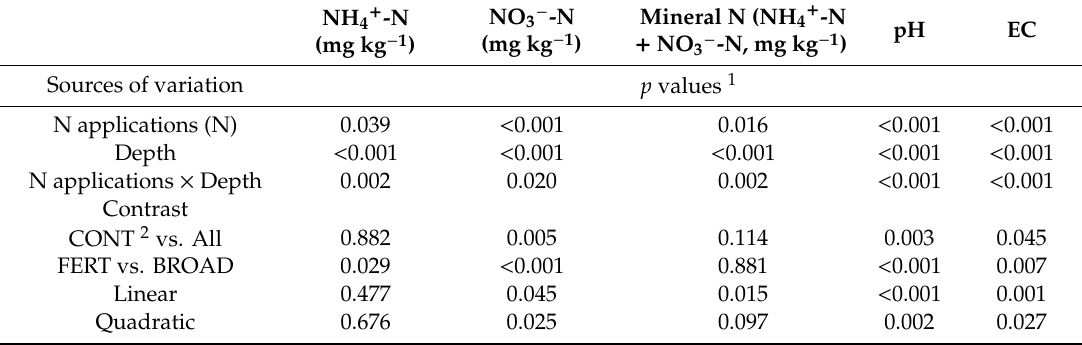
Table 2. Results of ANOVA for the e ff ects of nitrogen applications through fertigation (FERT) and broadcast (BROAD) methods and soil depth (sawdust layer, 0–30 cm and 30–60 cm) on the concentrations of ammonium N (NH 4 + -N), nitrate N (NO 3 − -N), mineral N (NH 4 + -N + NO 3 − -N), soil pH and